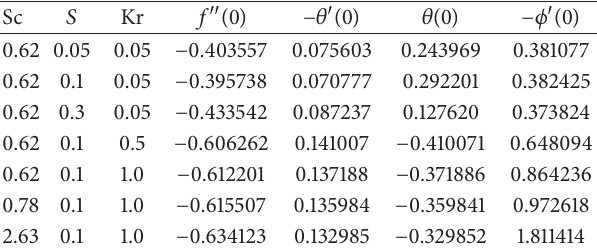
Table 3: Computation of skin friction ( 𝑓 󸀠󸀠 (0) ), Nusselt number ( −𝜃 󸀠 (0) ), plate surface temperature ( 𝜃(0) ), and Sherwood number ( −𝜙 󸀠 (0) ) for different values of Sc ,𝑆 , and Kr. The other parameters are fixed at Bi = Gc = Gr = 0.1 , Pr = 0.72 , and Nc = 0.01 .